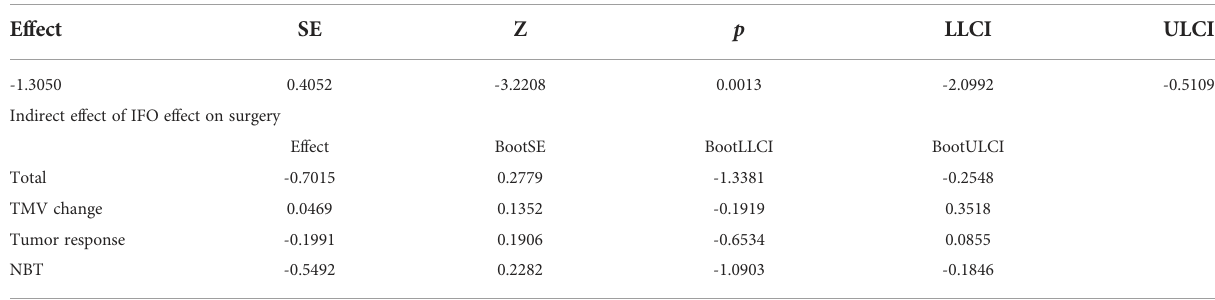
TABLE 4 Direct and indirect effect of IFO on